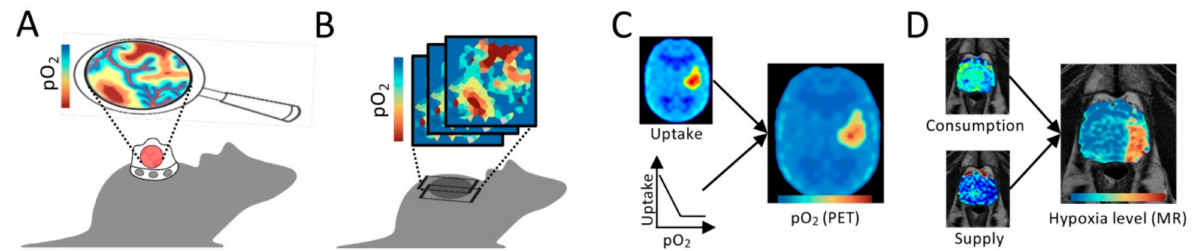
Figure 4. Imaging of hypoxia levels. ( A ) Optical pO 2 imaging of tumor in a dorsal skinfold chamber. The image with hypoxia level distribution is indicated. ( B ) Electron paramagnetic resonance (EPR) imaging of a tumor grown on the mouse back. Images with hypoxia level distribution are indicated. ( C ) Illustration of a positron emission tomography (PET) image showing uptake of hypoxia specific tracer (left), and pO 2 image based on the converted PET signal (right). The relationship between uptake (PET signal) and pO 2 is indicated. ( D ) Diffusion weighted (DW) magnetic resonance (MR) images showing apparent diffusion coefficient (ADC), reflecting oxygen consumption, (left, upper) and fractional blood volume (fBV), reflecting oxygen supply (left, lower), and the combined hypoxia level image (right). The images were collected from a patient with prostate cancer, and the DW-MR images are overlaid on T 2 weighted images of the pelvis. ( A – D ) Hypoxia levels are indicated by the color code, with approximate oxygen concentrations (% O 2 ) and tensions (mmHg) provided by the x -axis in Figure